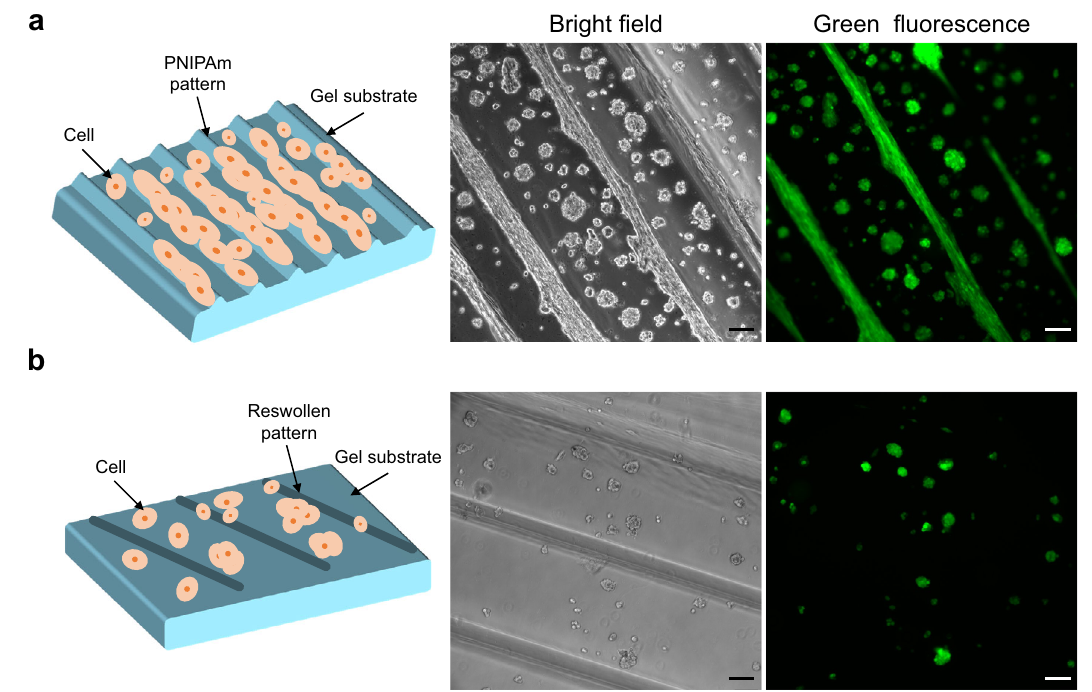
Fig. 5 | An example to show biological application of PNIPAm-patterned DN hydrogelsurfaces.a , b Illustration,bright fi eldandgreen fl uorescencemicroscope images of cells cultured on the surface of DN hydrogel with PNIPAm strip pattern ( a )and on the surface ofDNhydrogel withinternal damaged strip patternmade in waterwithoutPNIPAm( b ).Preferentialandelongatedgrowthofcellpopulationon